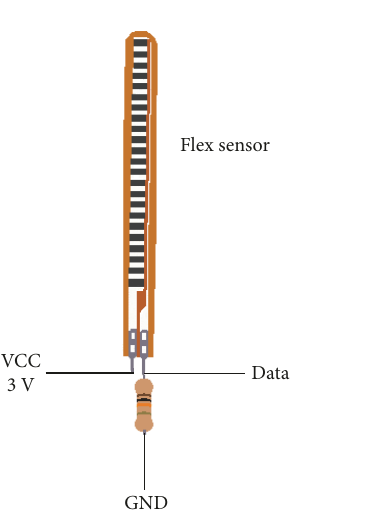
Figure 11: Electrical connections for the fl ex sensor.